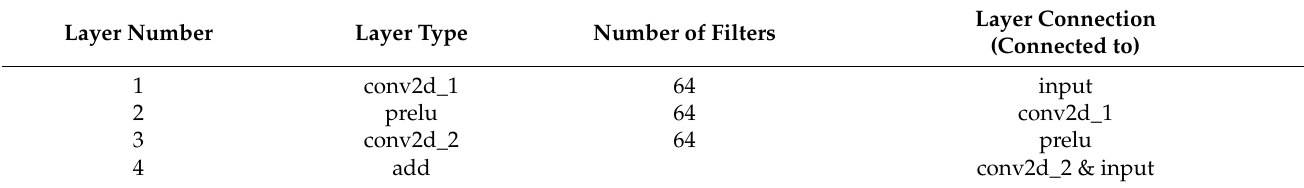
Table 6. Description of a residual block of the generator.